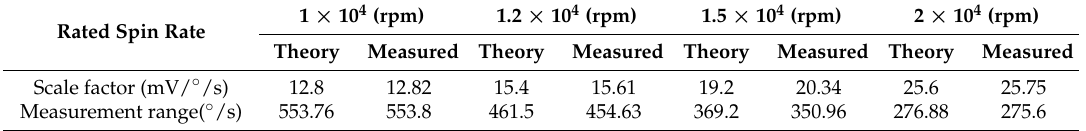
Table 1. Comparison between theoretical and experimental results at different spin rate settings.